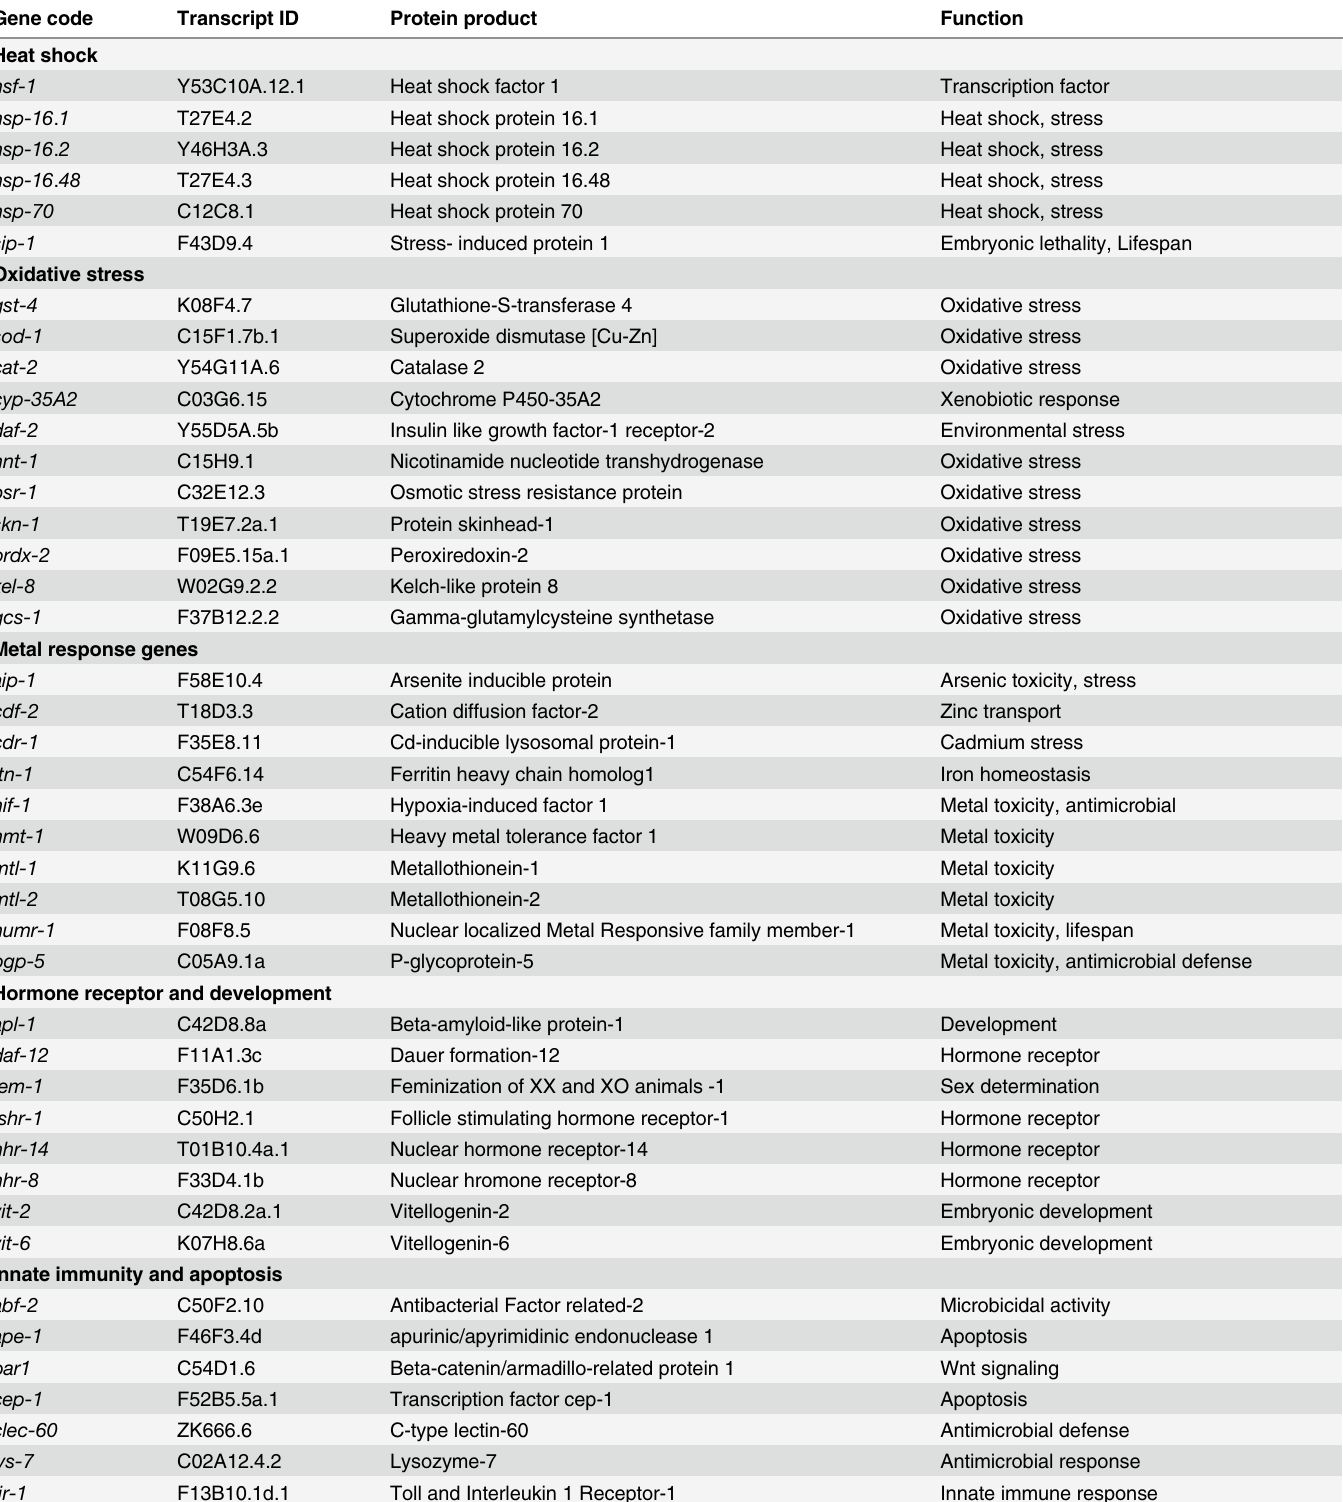
Table 1. Target genes used in the qPCR